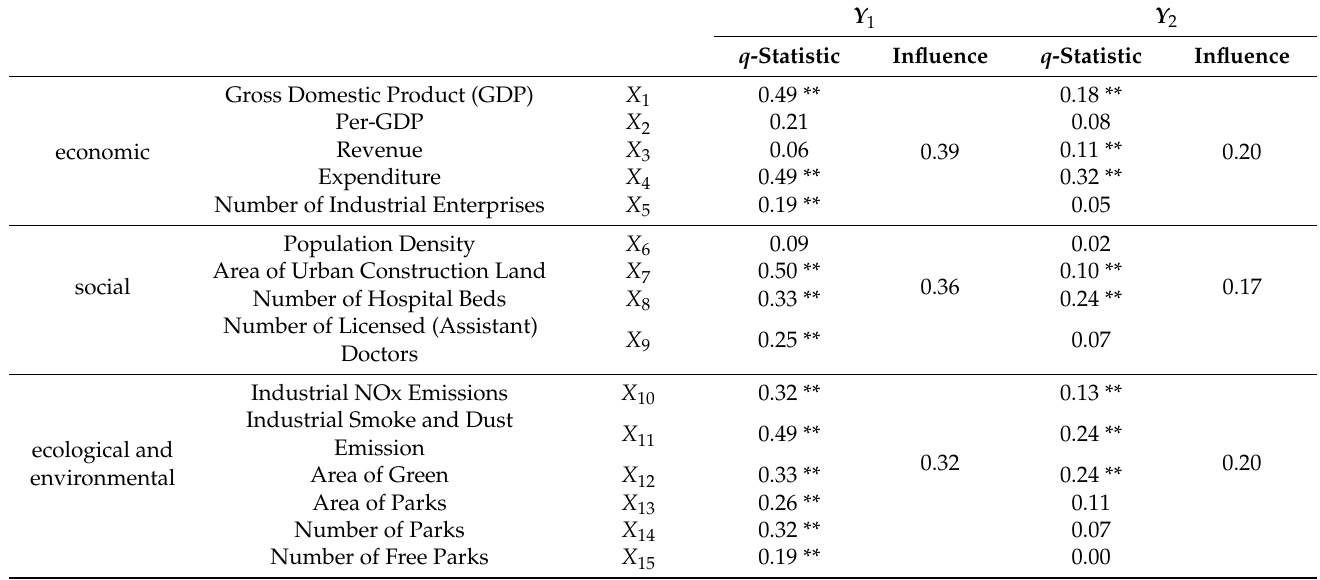
Table 4. Analysis of factor